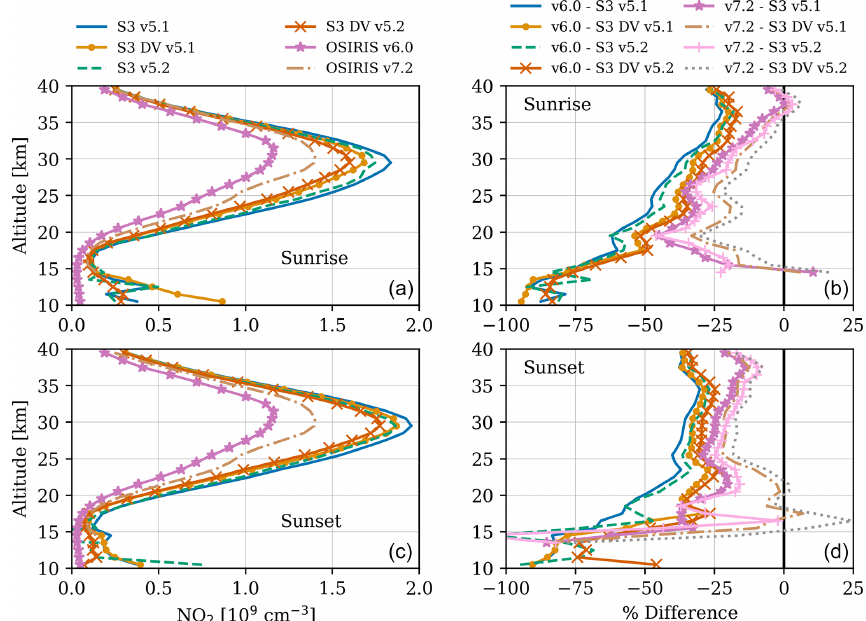
Figure 10. Comparison of mean coincident SAGE III/ISS and OSIRIS NO 2 profiles from − 25 to − 15 ◦ latitude. (a, b) SAGE sunrise occultations. (c, d) SAGE III/ISS sunset